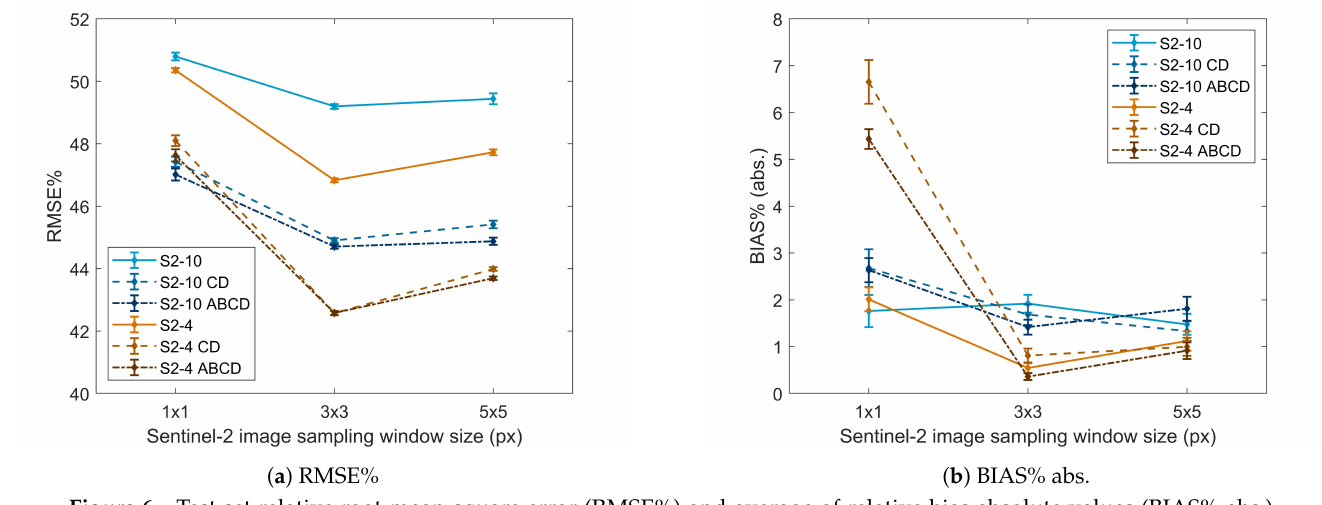
Figure 6. Test set relative root-mean-square error (RMSE%) and average of relative bias absolute values (BIAS% abs.) for DNN models with six different input feature combinations. All DNN networks consisted of three hidden layers. The whiskers show the 99% confidence intervals from 100 modeling